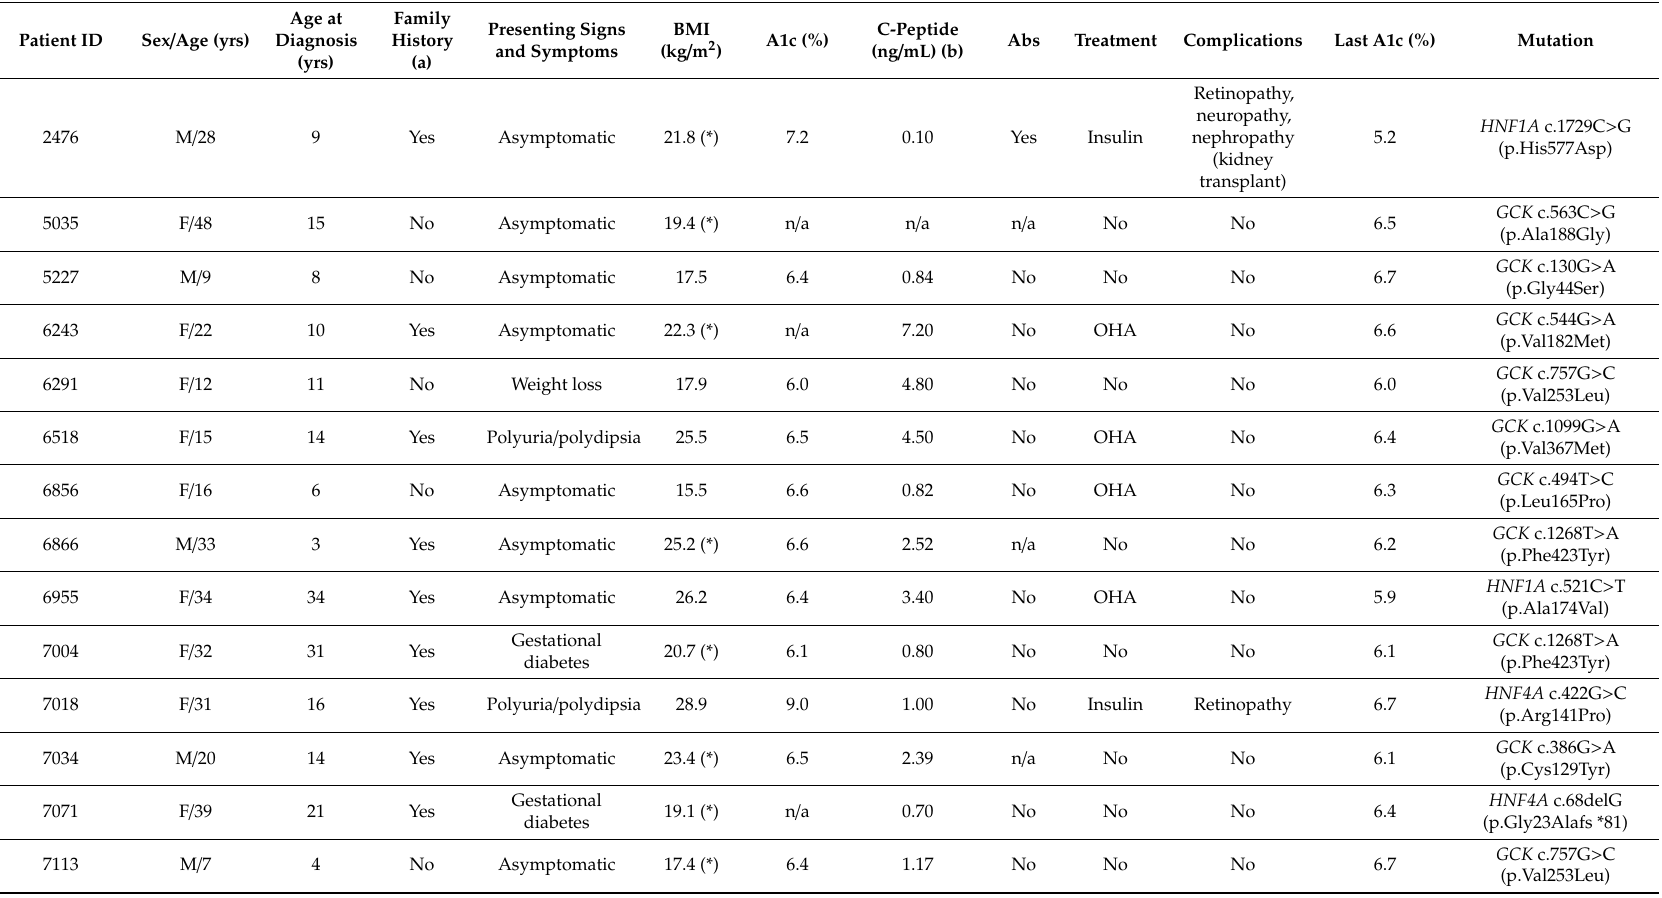
Table 2. Clinical characteristics of MODY patients with identified